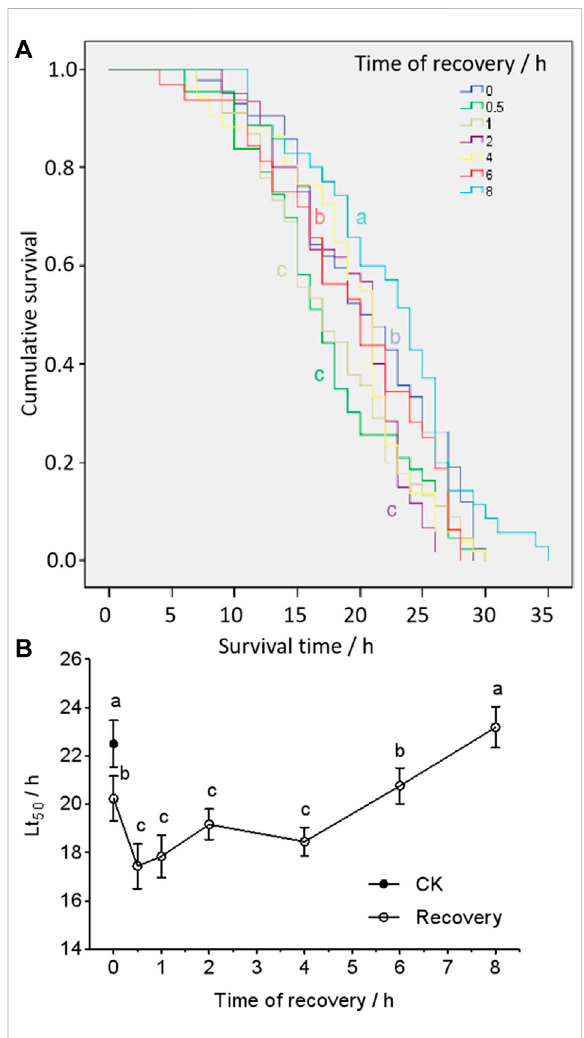
FIGURE 1 Cumulative survival curves (A) and medium lethal time (Lt 50 ) (B) oflarvaepost-heatshockat43 ° C,2 htreatment.Thecurves (A) were analyzed by a Kaplan – Meier analysis (chi-squared test), and Lt 50 s (B) were from the Kaplan – Meier calculation. The different letters (the color of the letter stands for the same color curve) represent a signi fi cant difference ( p <